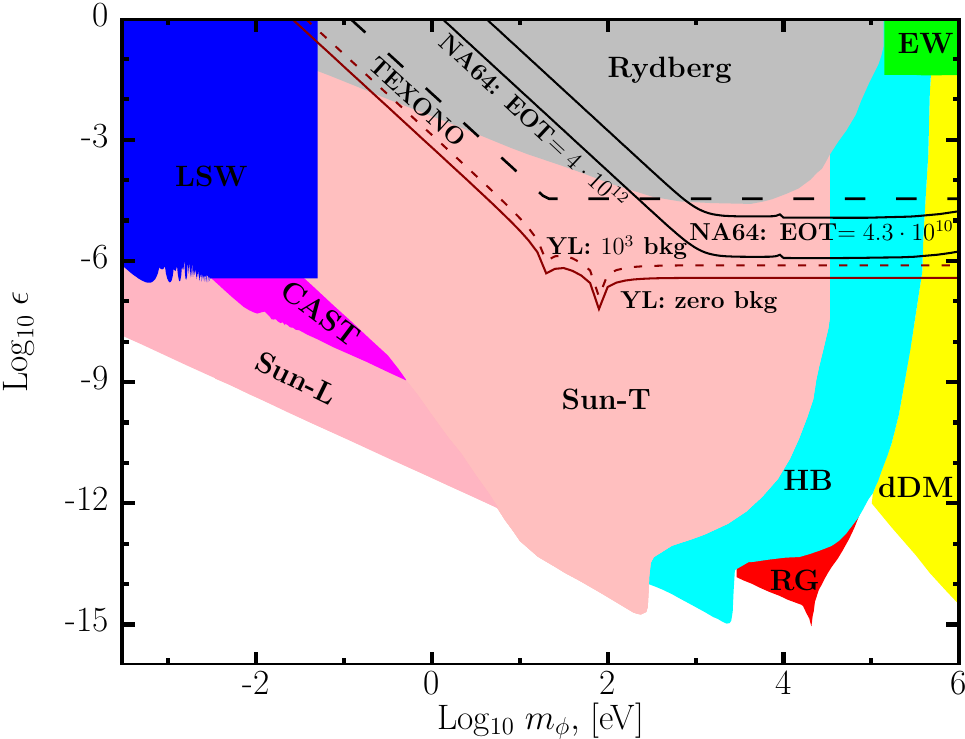
Figure 11 . The dark photon sensitivity from the γ ↔ A 0 oscillation for m φ < 2 m e at the Yemilab (YL) neutrino detector for one year of data taking with a 100 MeV–100 kW e − beam (zero back- ground: solid red line, 10 3 background: dotted red line) on a tungsten target (50 cm), compared to those of the recent direct search experiments, TEXONO (dashed black line) [29] and NA64 (two solid black lines) [27]. Details on the limits from the helioscopic/astrophysical observations and the other experiments are found in